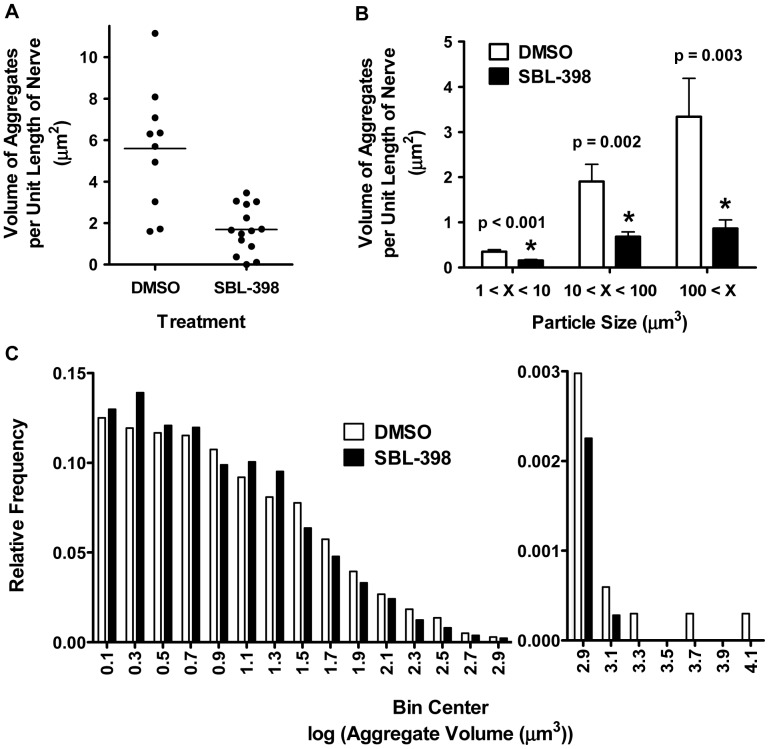
Reduction of neuronal aggregates by SBL-398; combined results.(A) Volumes of aggregates per unit length of nerve are plotted for khc/+; klc/+ larvae raised on media containing DMSO (N = 10 larvae) or 0.5 mM SBL-398 (N = 14 larvae). Each data point represents one animal. The large variance in the DMSO condition likely reflects incomplete penetrance (typical penetrance is about 0.7). Despite this variance, the mean values differ significantly (p<0.001, unpaired t test). (B) Mean volumes of aggregates per unit length of nerve are shown for three classes of aggregate sizes in DMSO-treated (N = 10; white bars) and SBL-398-treated (N = 14; black bars) larvae. Aggregate volumes per length of nerve are significantly (*) lower in SBL-398-treated larvae regardless of size class (t test with Bonferroni method to determine significance [120], [121]). (C) For both DMSO- and SBL-398-treated animals, aggregates greater than 1 µm3 were distributed among 0.2 log unit-wide bins. The frequency distribution of the aggregates is shown for DMSO-treated (white bars; 3,359 objects) and SBL-398-treated larvae (black bars; 3,551 objects). The differently scaled y-axis for bins containing the largest aggregates allows visual discrimination of histograms throughout the entire range of aggregate volumes. SBL-398 significantly shifts the size distribution of aggregates to smaller volumes (Mann Whitney test; p<0.001).